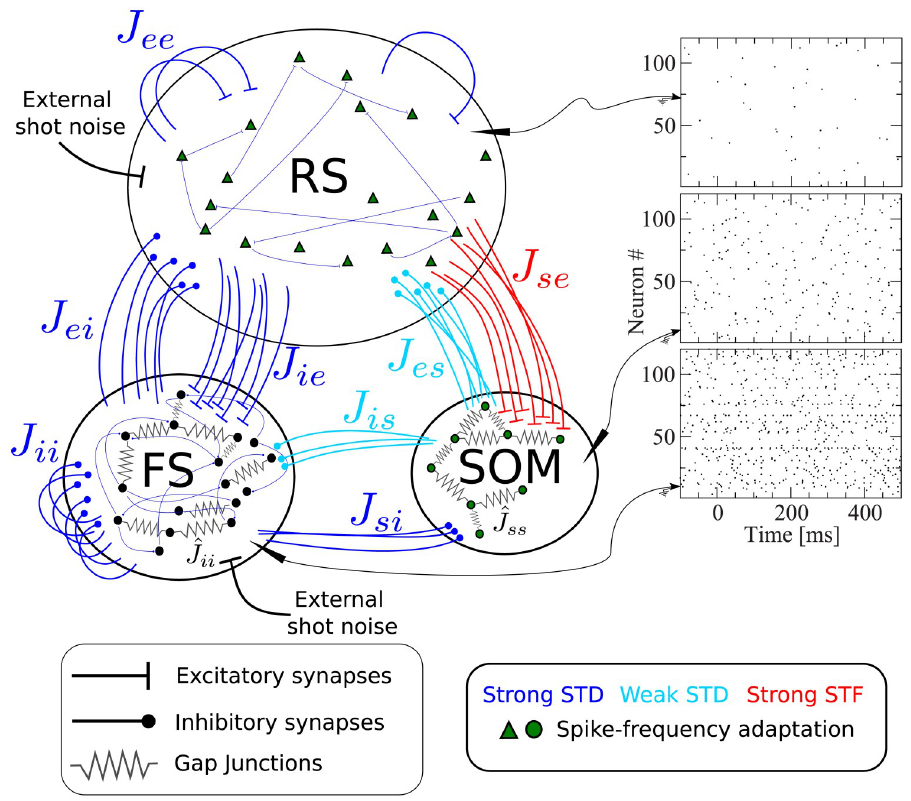
Fig 1. Recurrent network model representing the surroundings of the stimulated cell. The network is formed by N = 2000 excitatory regular spiking (RS) neurons, N i = 400 inhibitory fast spiking (FS) neurons, and N s = 200 inhibitory somatostatin-positive low-threshold spiking (SOM-LTS) neurons. Recurrent connections between RS neurons are sparse (15%), all connections involving FS neurons as well as those between RS and SOM-LTS neurons are dense (40%-50%). FS and SOM-LTS neurons are electrically coupled (only neurons of the same type). Gap junctions are represented by an effective all-to-all spiking coupling (see main text). Connections in blue are strongly depressing, connections in light blue are weakly depressing, and connections in red are strongly facilitating. RS and SOM-LTS neurons are endowed with a spike-frequency adaptation current. Input from the thalamus and from neighboring cortical regions is represented by Poissonian shot noise. SOM-LTS neurons do not receive external shot noise. The three raster plots show the spontaneous activity of 120 (from top to bottom) RS, SOM, and FS neurons, respectively. The spontaneous activity of all three populations is asynchronous and